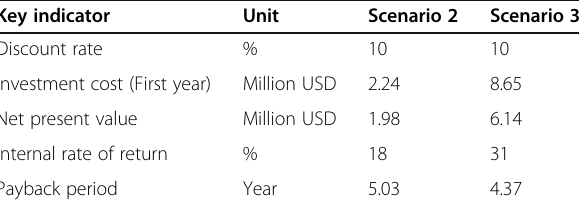
Table 2 Key indicators of Scenarios 2 and 3 Key indicator